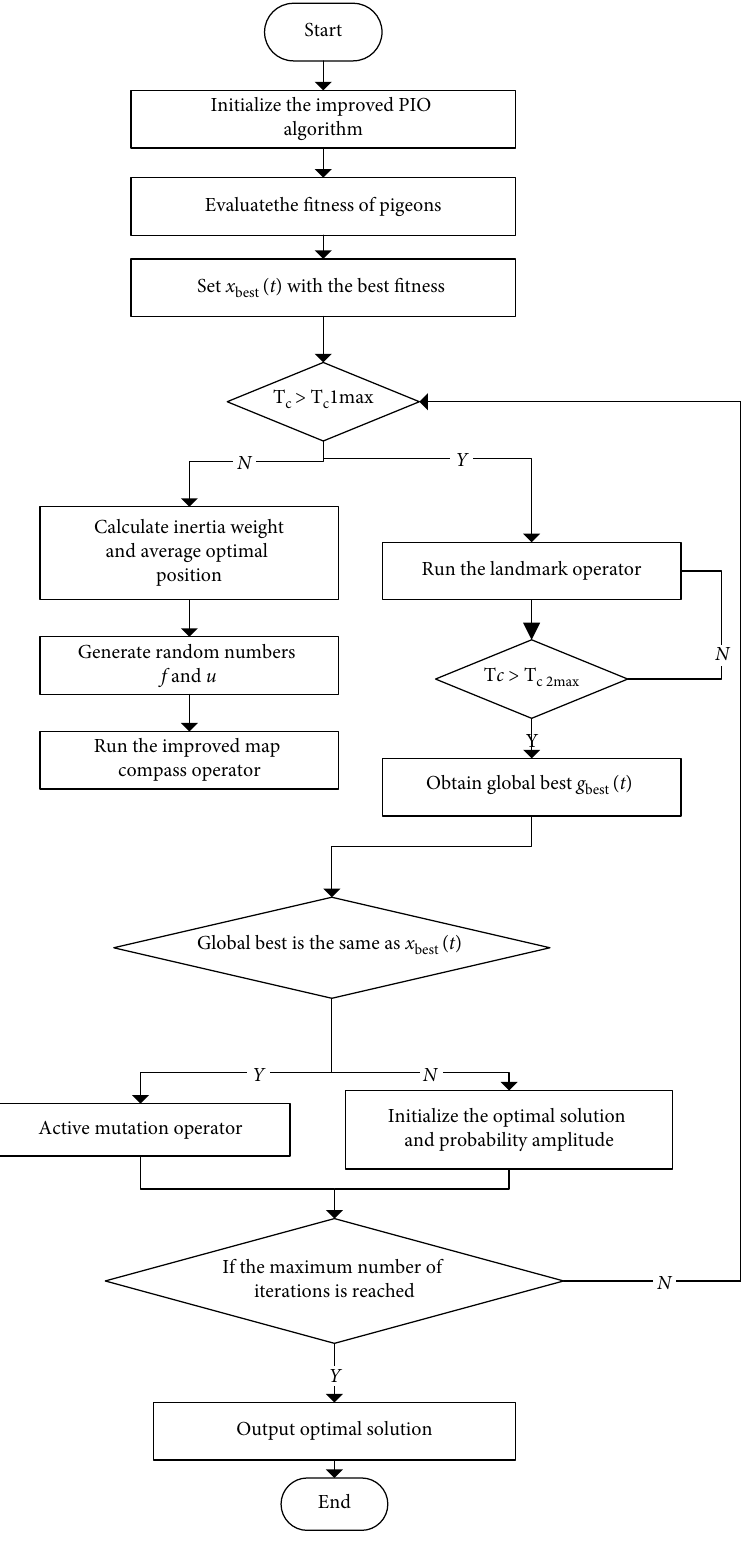
Figure 3: The procedure of the improved PIO